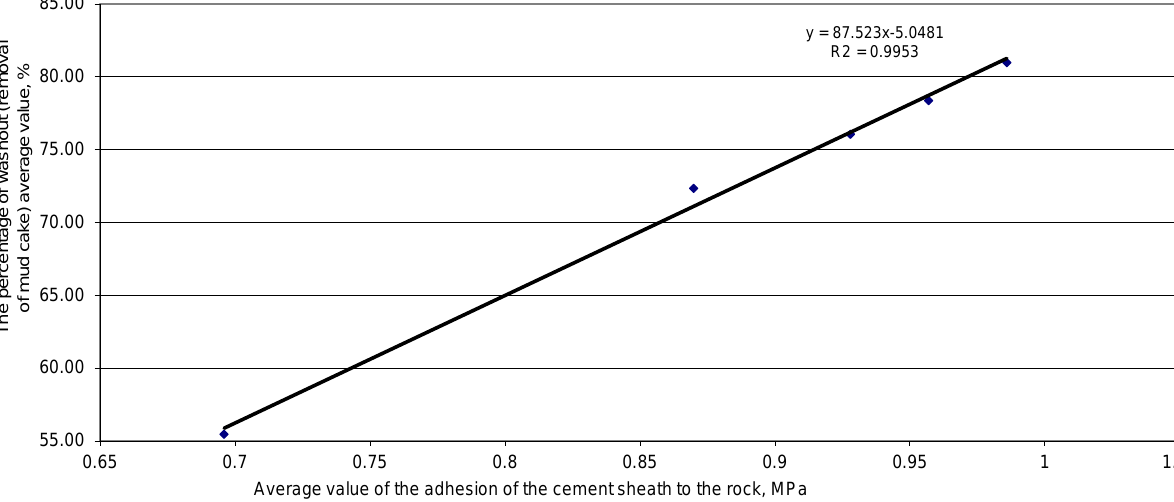
Figure 8. The relationship between the efficiency of mud cake removal and the adhesion of the cement sheath on contact with the rock formation.